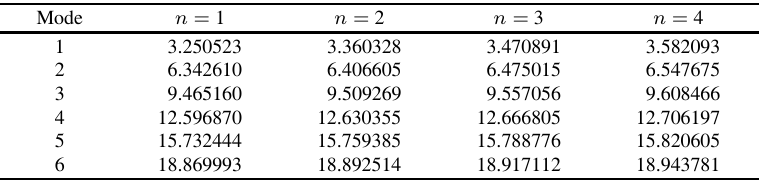
Table 10 Non-dimensional natural frequencies of free-free rods with A ( x ) = A 0 sin n ( ax + b )